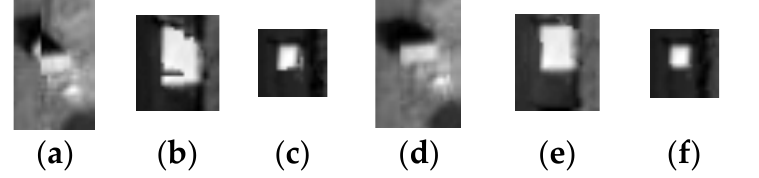
Figure 11. ( a , b ) Brightness temperature (BT) maps for LWIR1 a and LWIR1 b . ( c–e ) Transformed images with global homography, after blockwise refinement, and after pixelwise refinement, respectively. ( f–h ) Corresponding SSIM maps between the transformed image and reference image (BT map of LWIR1 b ) for global homography, blockwise refinement, and pixelwise refinement, respectively.